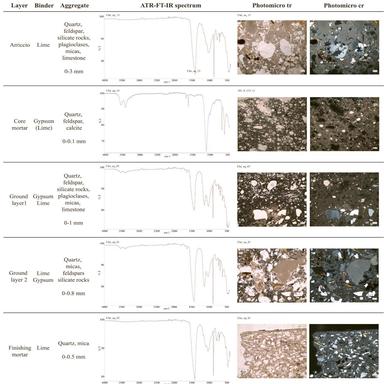
Comparison of the layers of the three-dimensional stucco decoration. For each layer is indicated: the composition of the binder and aggregates, an example of a reference ATR-FT-IR spectrum and an example of a thin section photomicrograph in transmitted light (parallel and crossed nicol). Measurement reference bar = 200 μm.